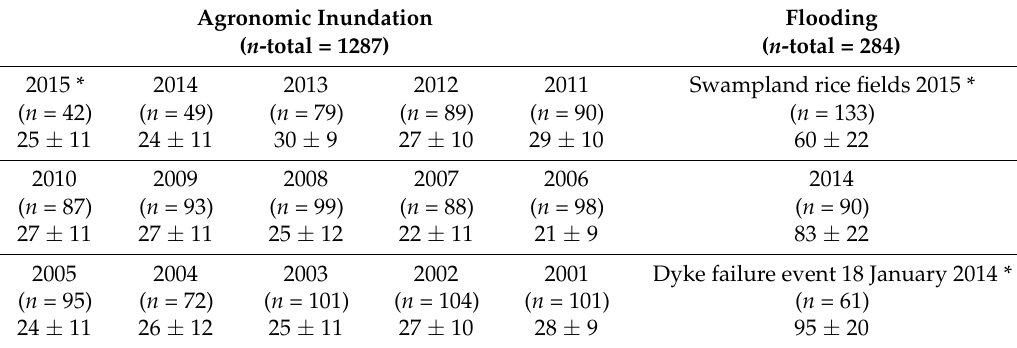
Table 4. Duration (Mean ± Stdev, in days) of surface water (agronomic inundation and flooding) in irrigated rice fields per year derived from EVI from 2000/2001 to 2014/2015 ( n = number of pixels). Duration is the difference between transplanting date (SOS a ) and the date when agronomic inundation or flooding first